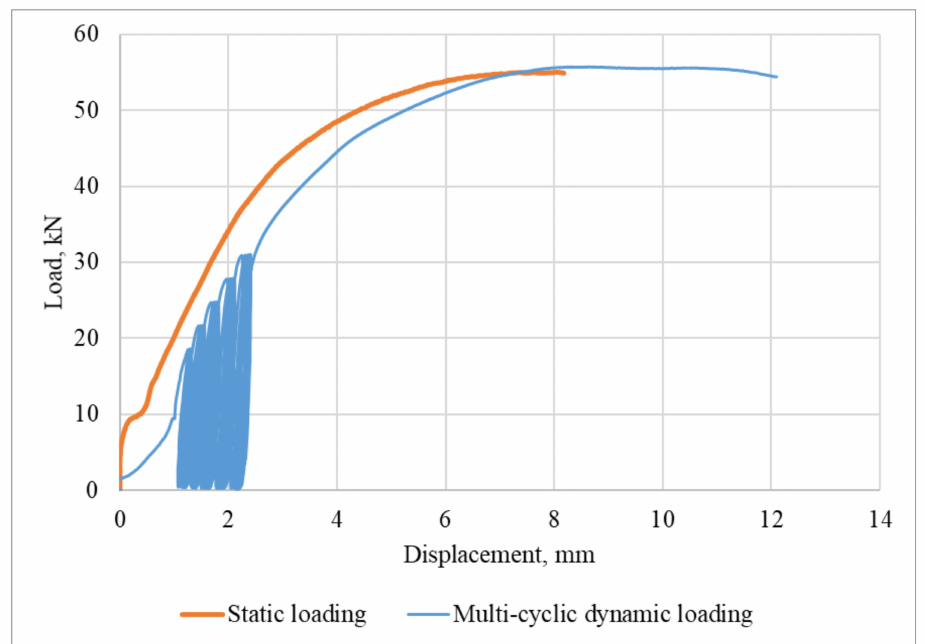
Figure 14. Characteristic load–displacement relationships under static loading and multi-cyclic dynamic loading, if the anchorage fails due to the slippage in the base at the initial stage of anchor loading and subsequent failure of the base